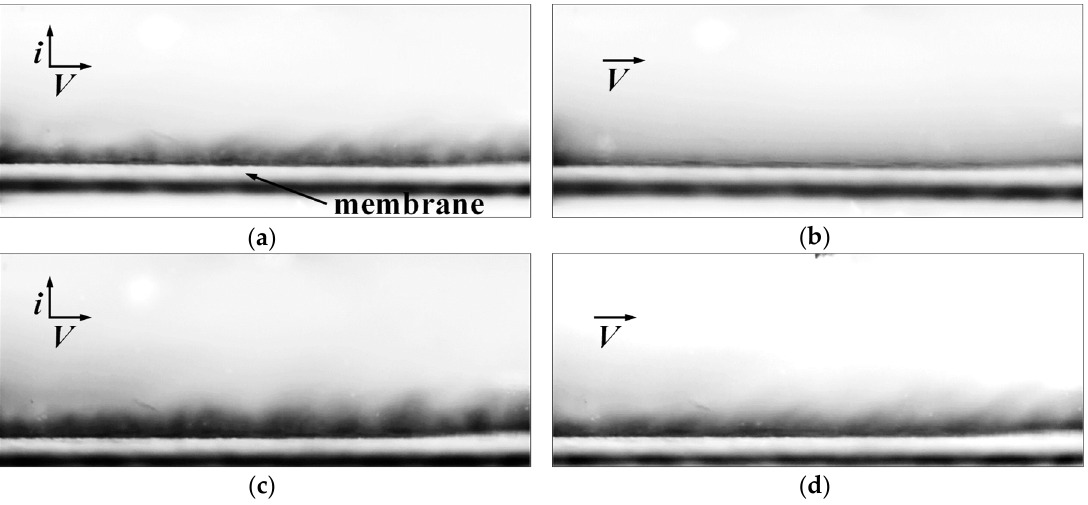
Figure 9. Visualization of the vortex structures at the Neosepta AMX membrane surface in the desalination channel of the electrodialysis cell in the DC mode at i = 3.0 i limLev ( a ) and in the absence of current ( b ), and in the PEF mode at i av = 3.0 i limLev ( f = 0.5 Hz, α = 1/2) at the pulse lapse of a direct current ( c ) and pause lapse of zero current ( d ).